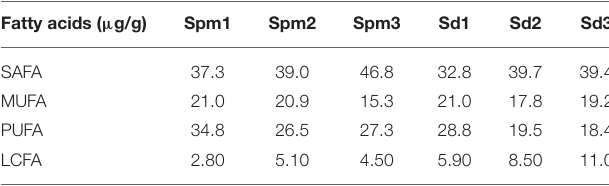
TABLE 5 | Concentrations of fatty acid biomarkers used in regressions